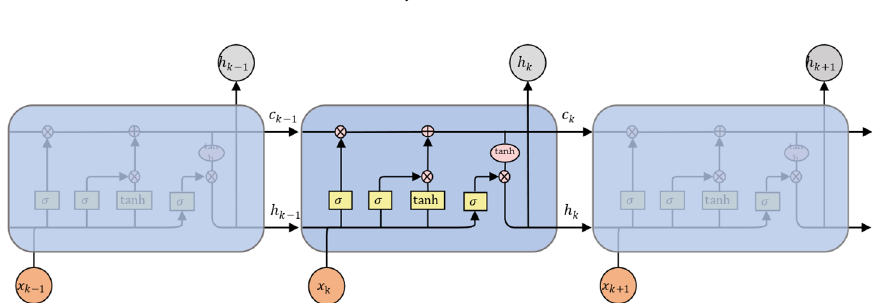
Figure 4. LSTM processing cell.